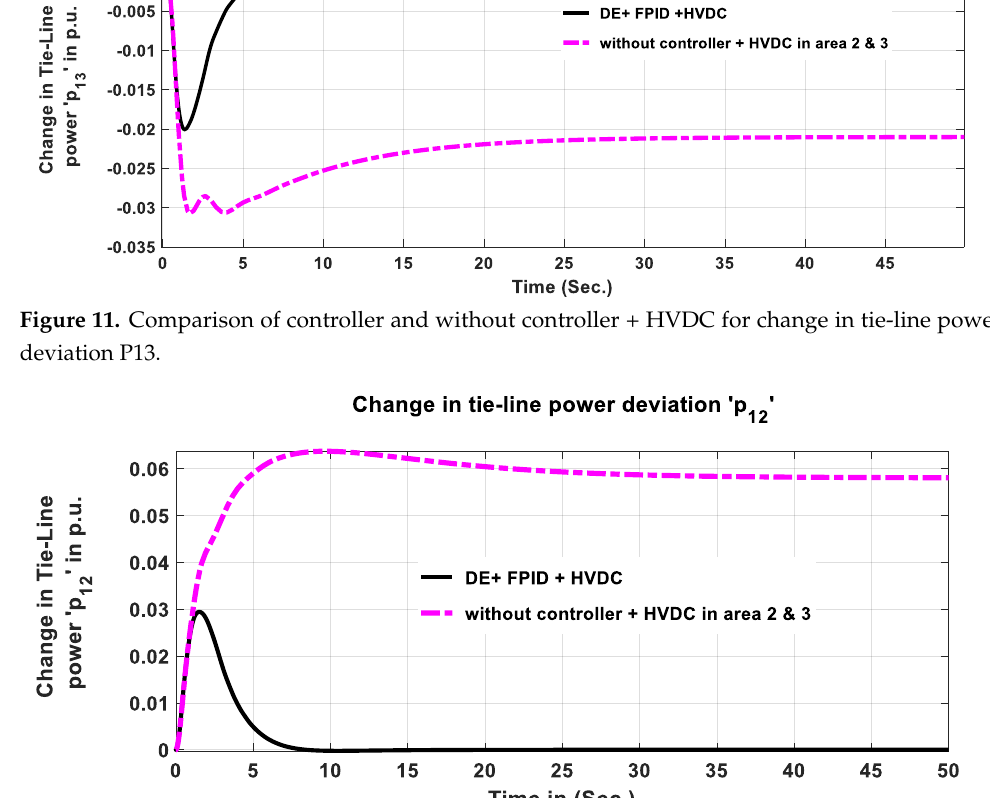
Figure 10. Comparison of controller and without controller for change in ACE 3.